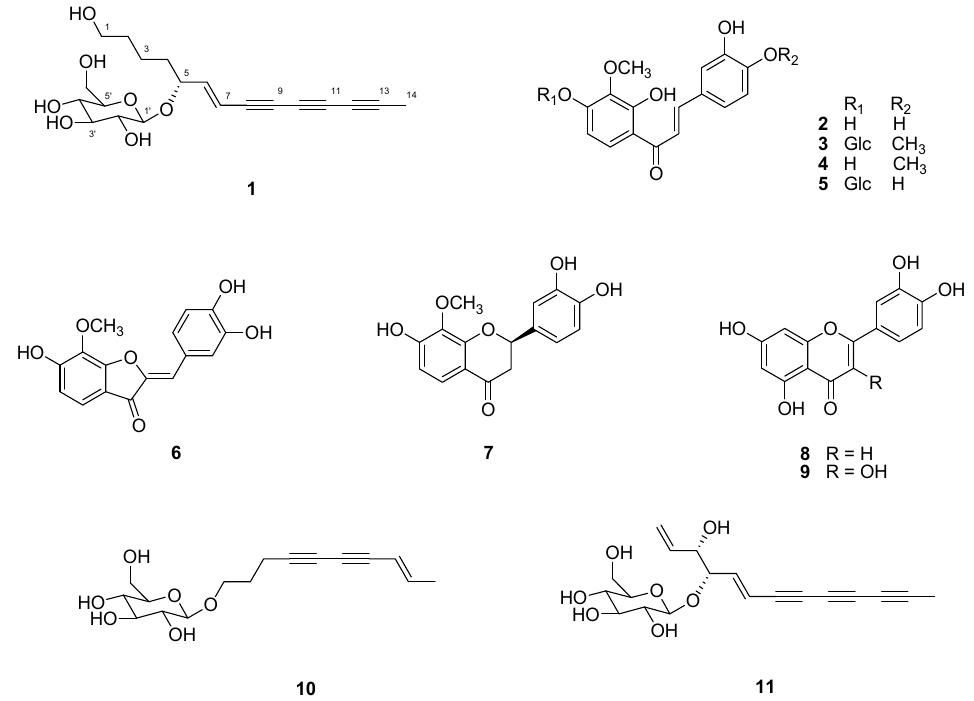
Figure 1. Chemical structures of compounds isolated from the ethyl acetate-soluble fraction of Coreopsis lanceolata .